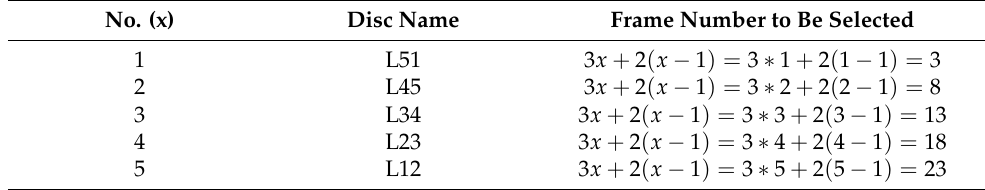
Table 1. The selection criteria of the lumbar disc axial view T2 image.